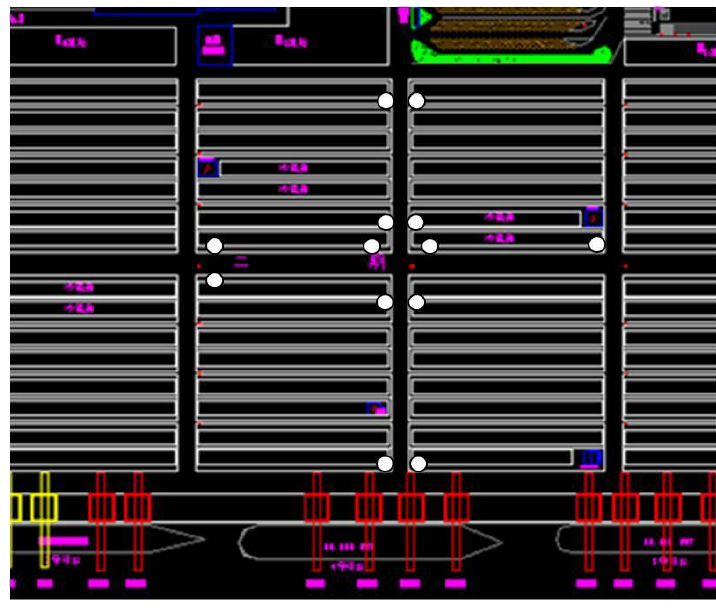
Figure 6. Location of placing